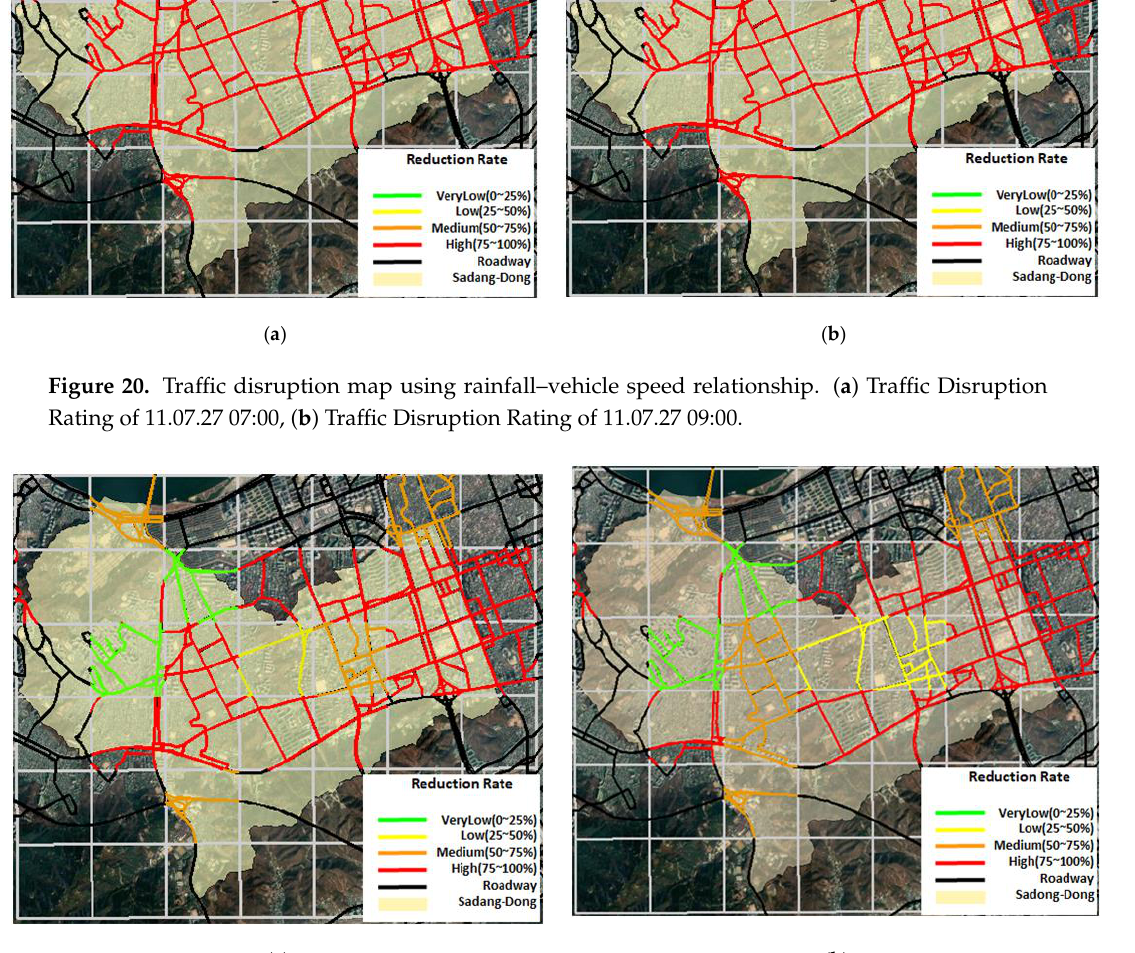
Figure 21. Tra ffi c disruption map using rainfall–depth–vehicle speed relationship. ( a ) Tra ffi c Disruption Figure 21. Traffic disruption map using rainfall – depth – vehicle speed relationship. ( a ) Traffic Rating of 11.07.27 07:00, ( b ) Tra ffi c Disruption Rating of 11.07.27 Disruption Rating of 11.07.27 07:00, ( b ) Traffic Disruption Rating of 11.07.27 09:00.